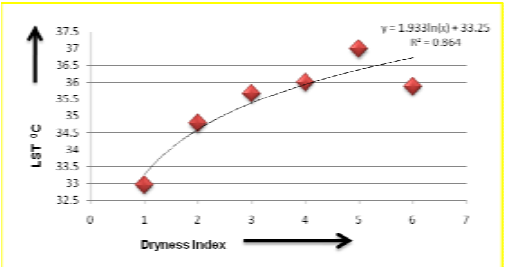
Figure 8: Graphical relation between LST and Dryness index